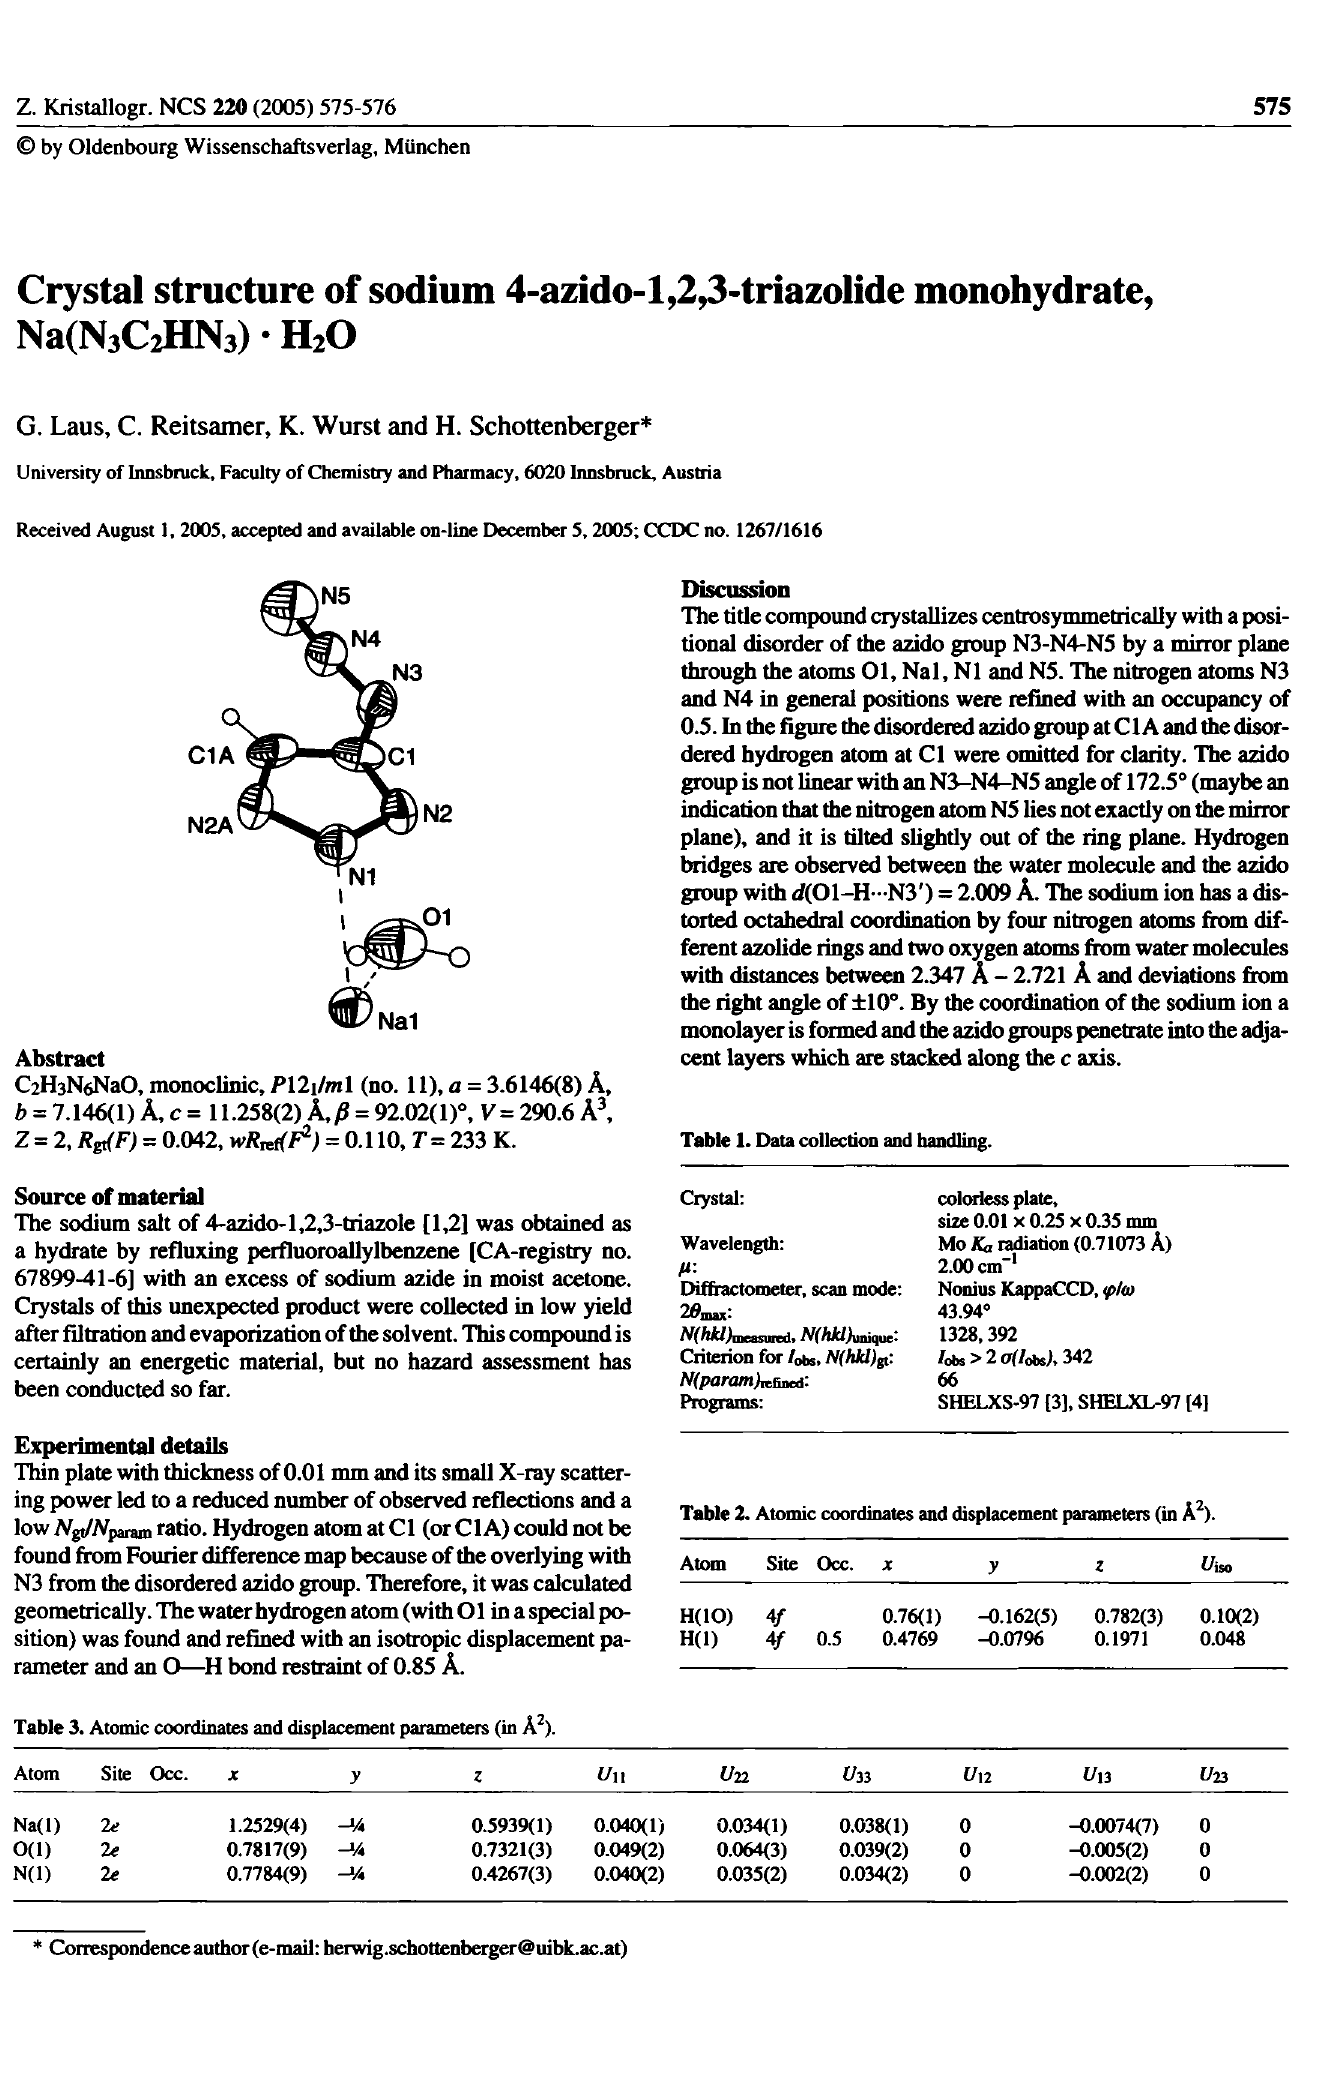
Table 3. Atomic coordinates and displacement parameters (in Ä 2 ). Atom Site